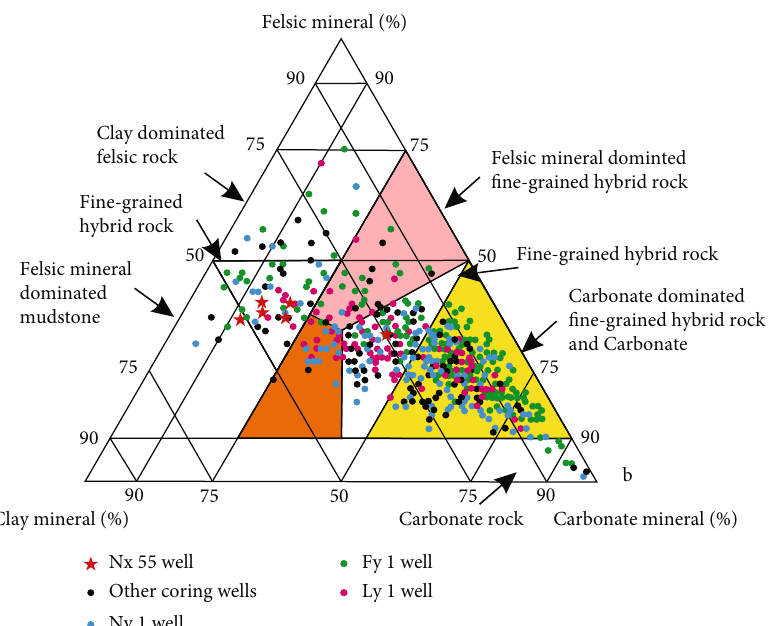
Figure 3: Mineral composition of X-di ff raction rock data in the Dongying Sag (Es4 U , 457